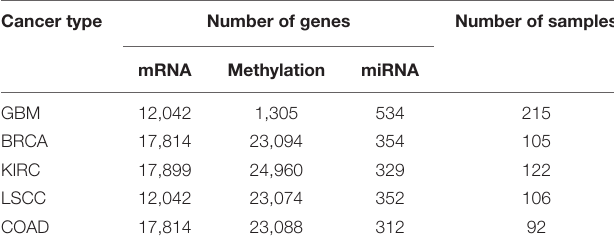
TABLE 1 | Detailed information on five types of cancer multi-omics data sets in Wang et al.